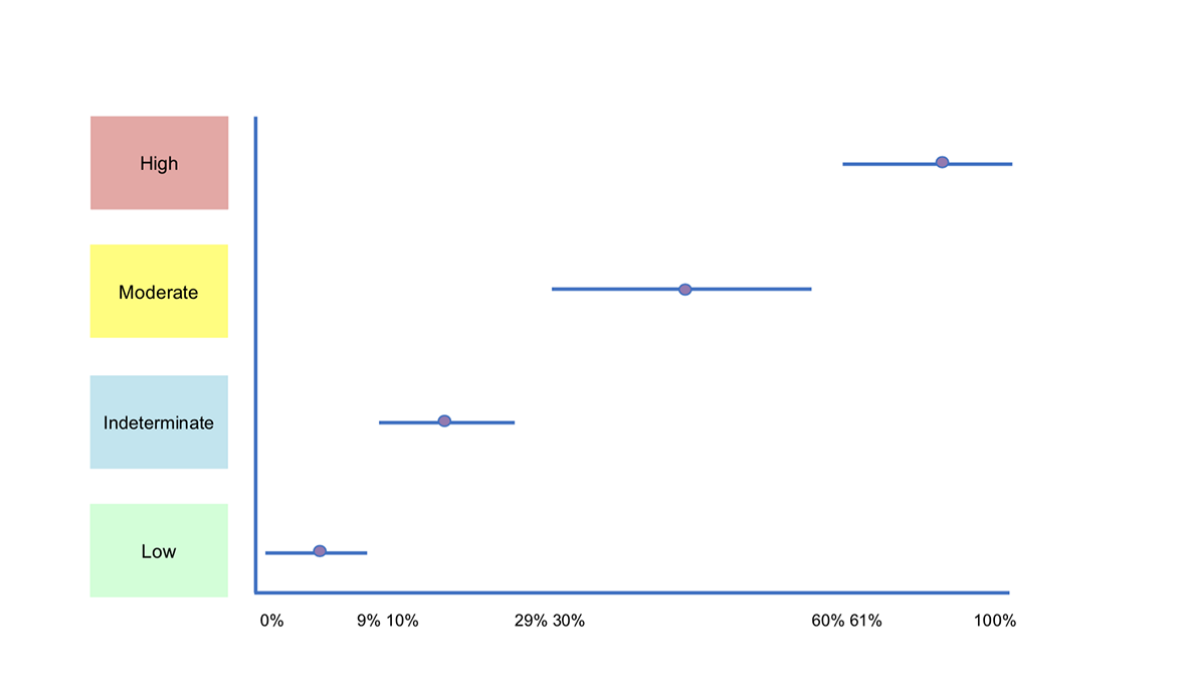
Figure 3. Sliding scale percent probability ranges. The blue bar indicates the range of percentages that fall into the high, moderate, indeterminate, and low categories. The purple circle illustrates the percentage typically used in the assignment of percent probability.